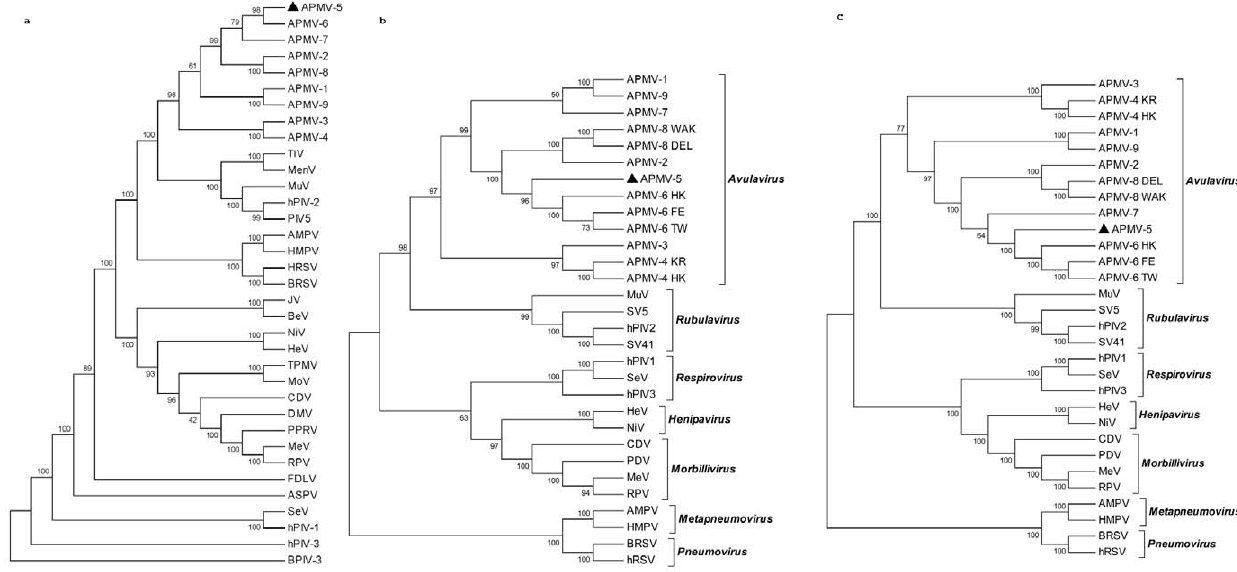
Figure 4. Phylogenetic tree of representative members of family Paramyxoviridae . Phylogenic analysis of the complete genome (a) and respective, F (b) and L (c) proteins of members of family Paramyxoviridae . The numbers represents the bootstrap values among different viruses. The phylogenetic trees were analyzed by average distance using MEGA 4.1, Molecular Evolutionary Genetics Analysis software.